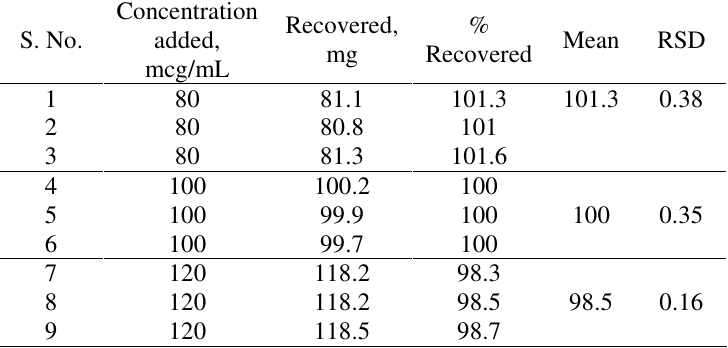
Figure 2. Linearity graph of atenolol. Table 2. Recovery data for the proposed RP-HPLC method